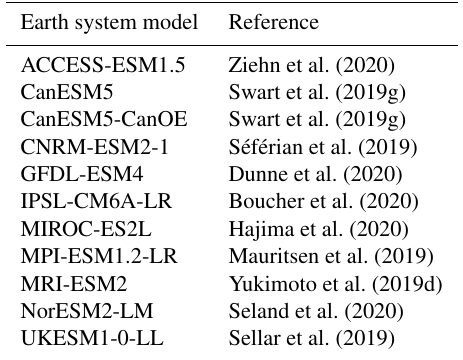
Table 1. List of the 11 CMIP6 Earth system models used in this study along with references for the model